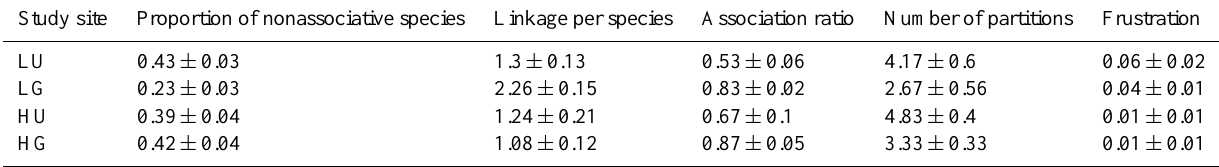
Table 3. Characteristics of the spatial association networks of the plant community at the four study sites in the middle Ebro Valley, Spain. Study